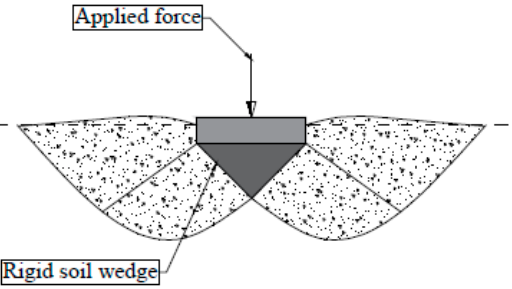
Figure 17. General shear failure mechanism occurring in sand according to Terzaghi mechanism (after [38,43]).